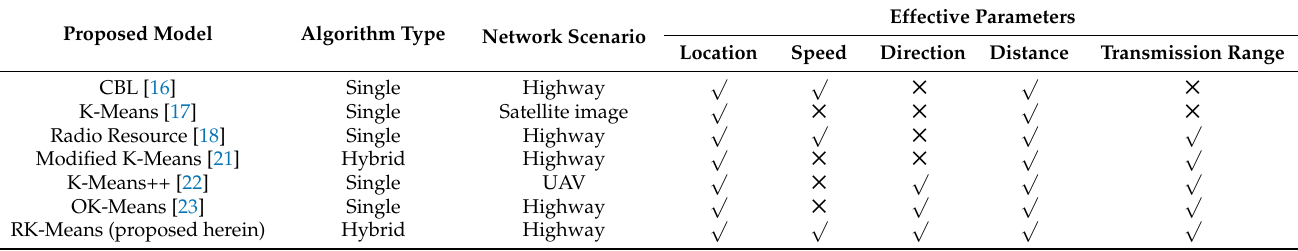
Table 2. RK-Means effective parameters compared with other clustering schemes in